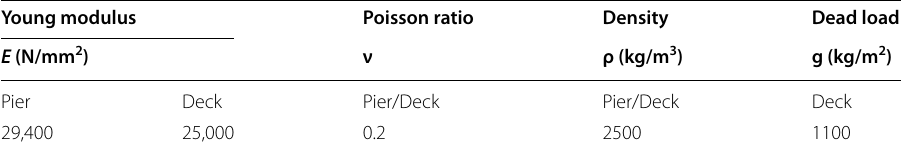
Table 1 Mechanical parameters of the RC bridge and dead loads Young modulus Poisson ratio Density Dead load E (N/mm 2 ) ν ρ (kg/m 3 )